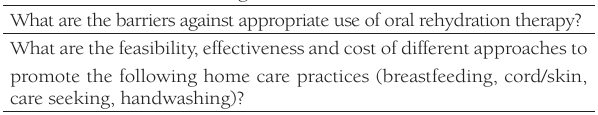
Table 1. The 4 research priorities (8%) that were identified as positive outliers in terms of their likelihood to obtain funding support Evaluate the quality of community workers to adequately assess, recog- nize danger signs, refer and treat acute respiratory infections (ARI) in different contexts and settings. What are the barriers against appropriate use of oral rehydration therapy?